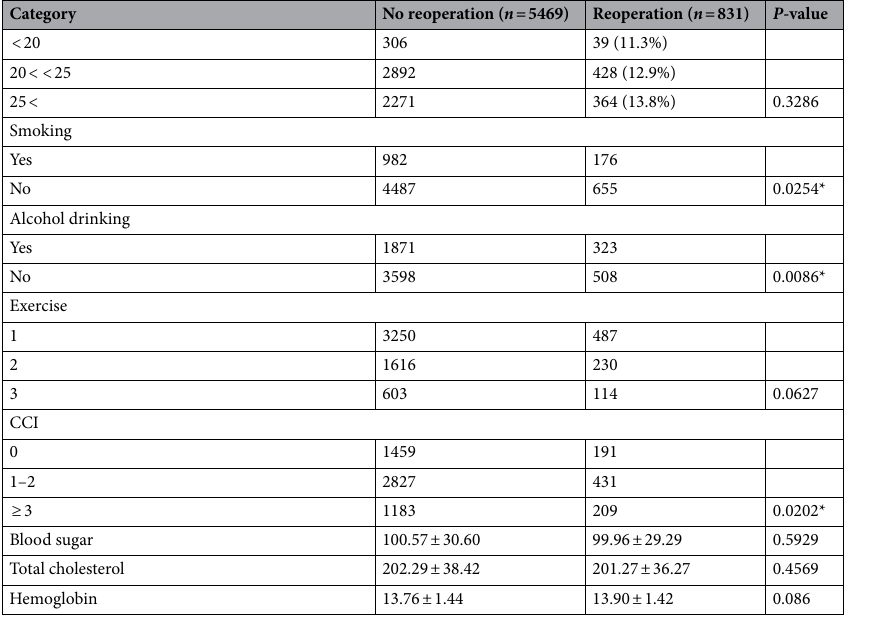
Table 2. Comparisons between the No reoperation and reoperation groups. PELD, Percutaneous endoscopic lumbar discectomy; BMI, Body mass index; CCI, Charlson comorbidity index. * Statistically significant.